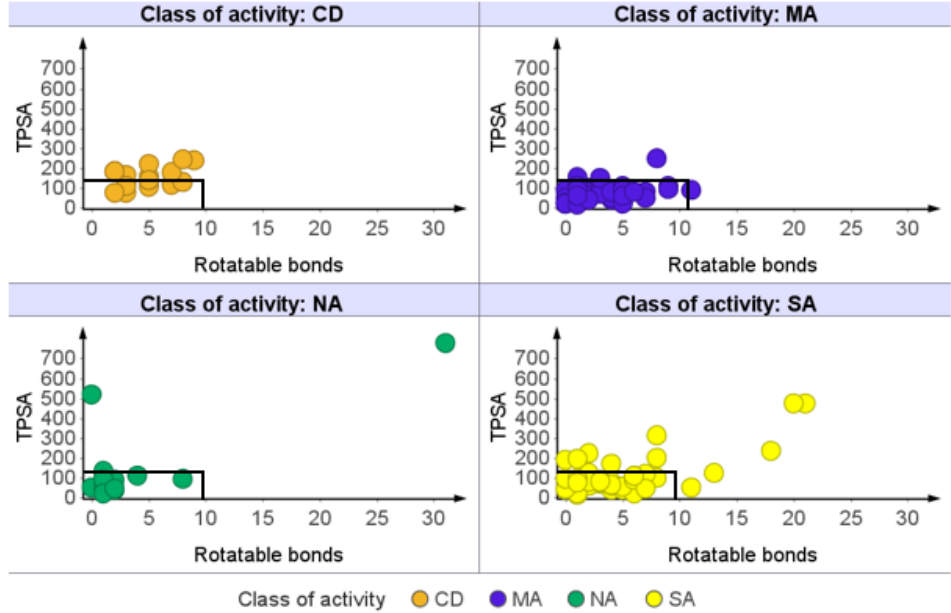
Figure 8. Prediction of oral absorption based on Veber’s model. Each of the panels represents a class of activity (CDs and subgroups of AMNPs). More than 78% of each of the categories of AMNPs and 53% of those of CDs (markers within the highlighted parts) obeyed Veber’s rule without any violation.